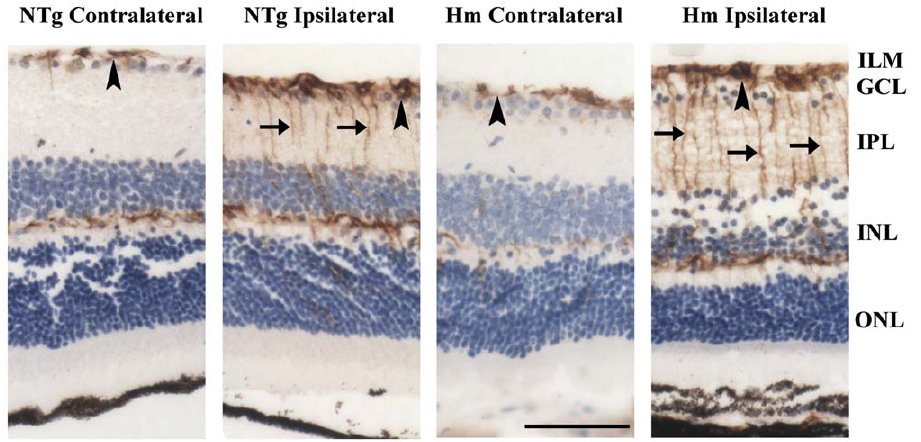
Figure 3. Immunohistochemical staining of glial fibrillary acidic protein (GFAP). Compared with the contralateral retinae of NTg and Hm TET-1 mice, GFAP signal was up-regulated in the ipsilateral retinae in the astrocytes around capillaries in the inner limiting membrane (arrowheads) and the Mu¨ller cell processes in IPL (arrows). n=5 for each experimental group. Scale bar=50 m m. doi:10.1371/journal.pone.0026184.g003 PLoS ONE |